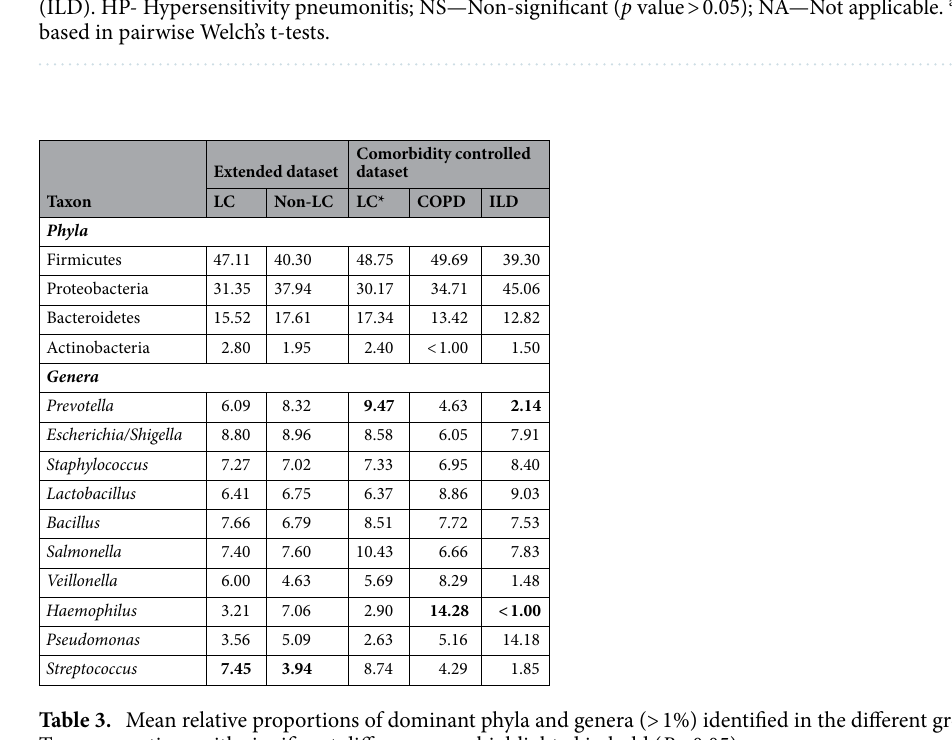
Table 3. Mean relative proportions of dominant phyla and genera (> 1%) identified in the different groups. Taxa proportions with significant differences are highlighted in bold ( P < 0.05).